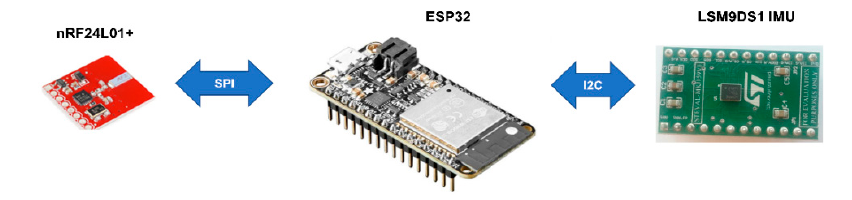
Figure 2. Hardware configuration of sensor node.